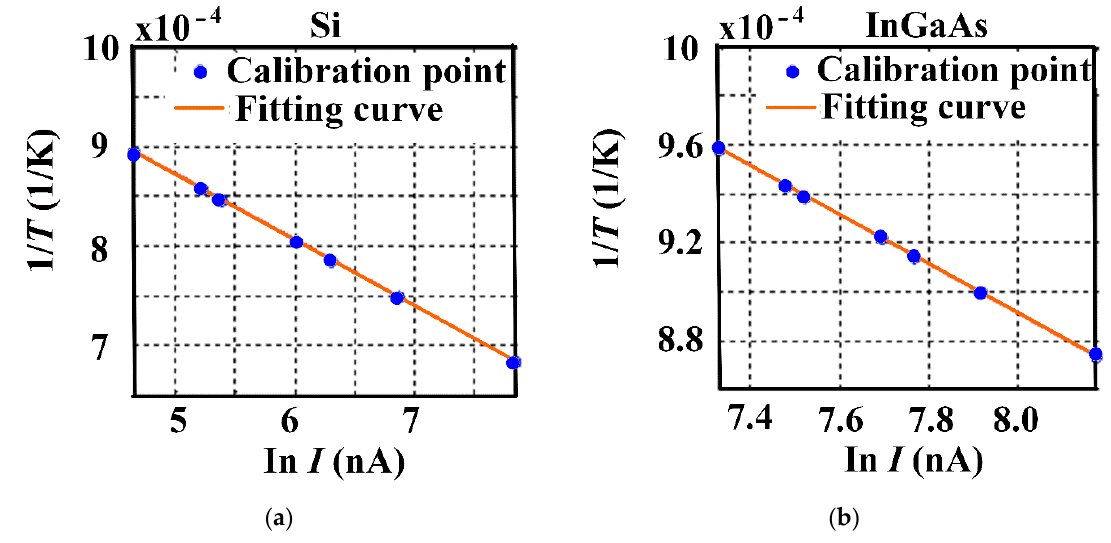
Figure 3. Schematic diagram of calibration results of the pyrometer: ( a ) result of line fit of calibration of the first waveband (Si, 600~1000 °C); ( b ) result of line fit of calibration of the second waveband (InGaAs, 600~1000 °C).